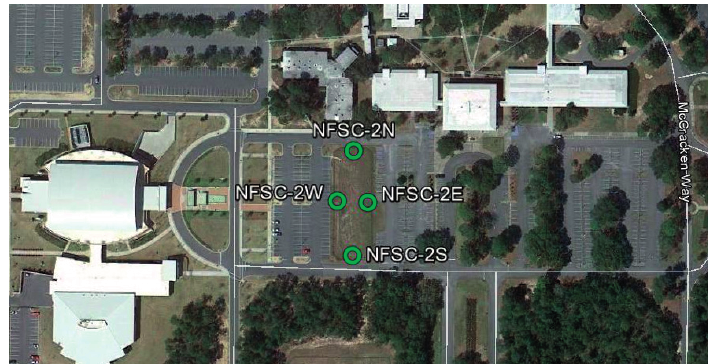
Figure 1. Plan view of new marks in Phase 1